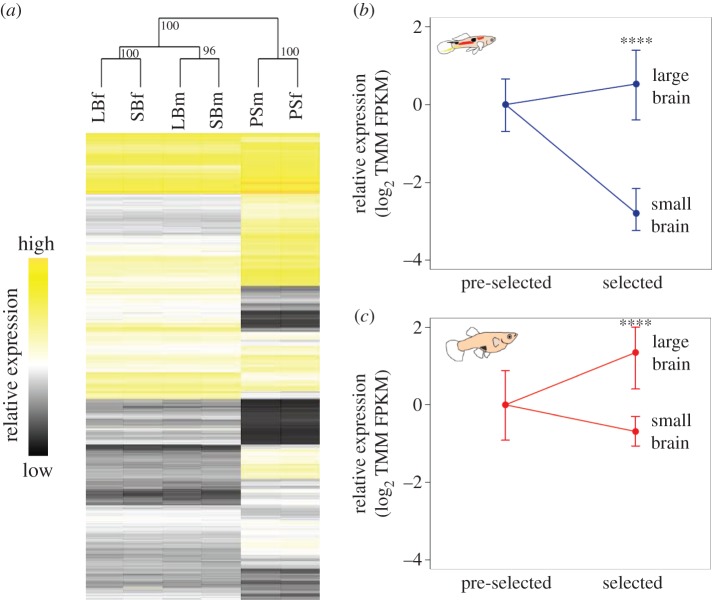
Expression profiles of guppy populations. (a) Hierarchical clustering of gene expression across all significantly expressed genes in LBf, LBm, SBf, SBm and PSm, and PSf telencephalons. Clustering is based on Euclidian distance of expression level, with significance provided by 1000 bootstrap replicates shown on each node. Yellow indicates relative higher and black relative lower expression for each transcript. (b) Relative expression of Ang-1 in pre-selected and selected male populations. (c) Relative expression of Ang-1 in pre-selected and selected female populations. In both (b,c), expression is based on log2 relative trimmed mean of M-values (TMM) normalized FPKM mapped reads. Tails indicate minimum and maximum expression values for each population. Significance of expression difference between large- and small-brained population pools, assessed with a t-test, is indicated in each panel (****Padj < 0.0001).